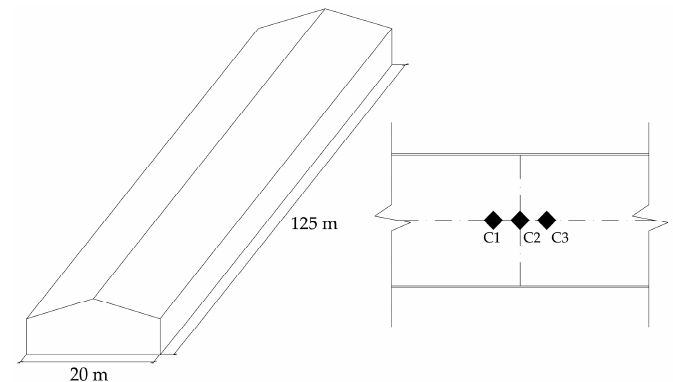
Figure 6. Geometry of the warehouse and location of cells inside.